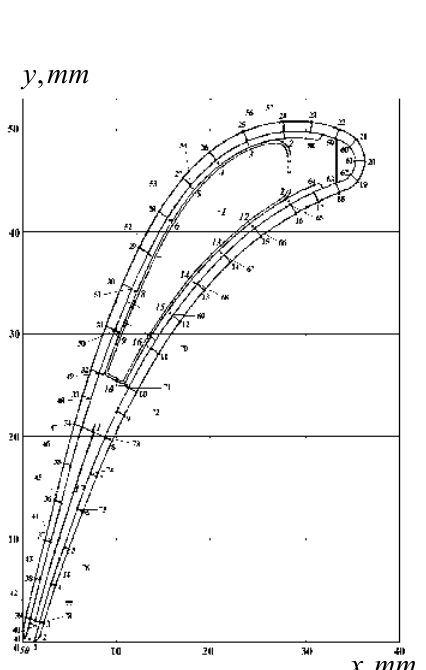
Fig 5. Geometrical model with foliation of design points of contour (1-78) and